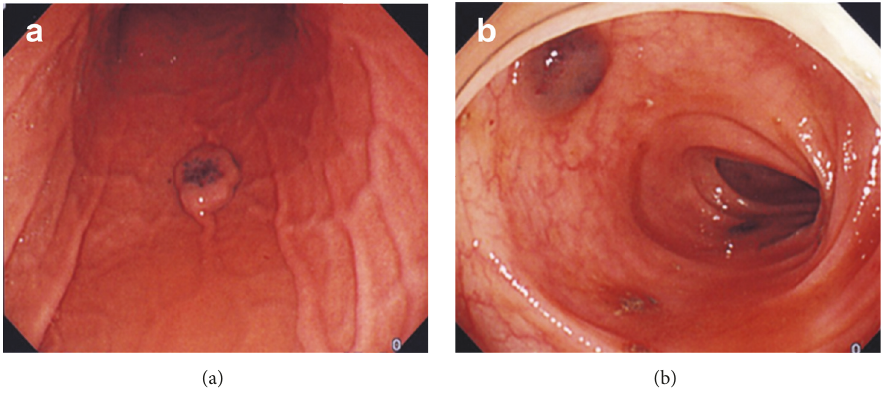
Figure 2: Endoscopic findings of venous malformations at 19 years of age. (a) On the posterior corpus of the stomach; (b) On the sigmoid colon.